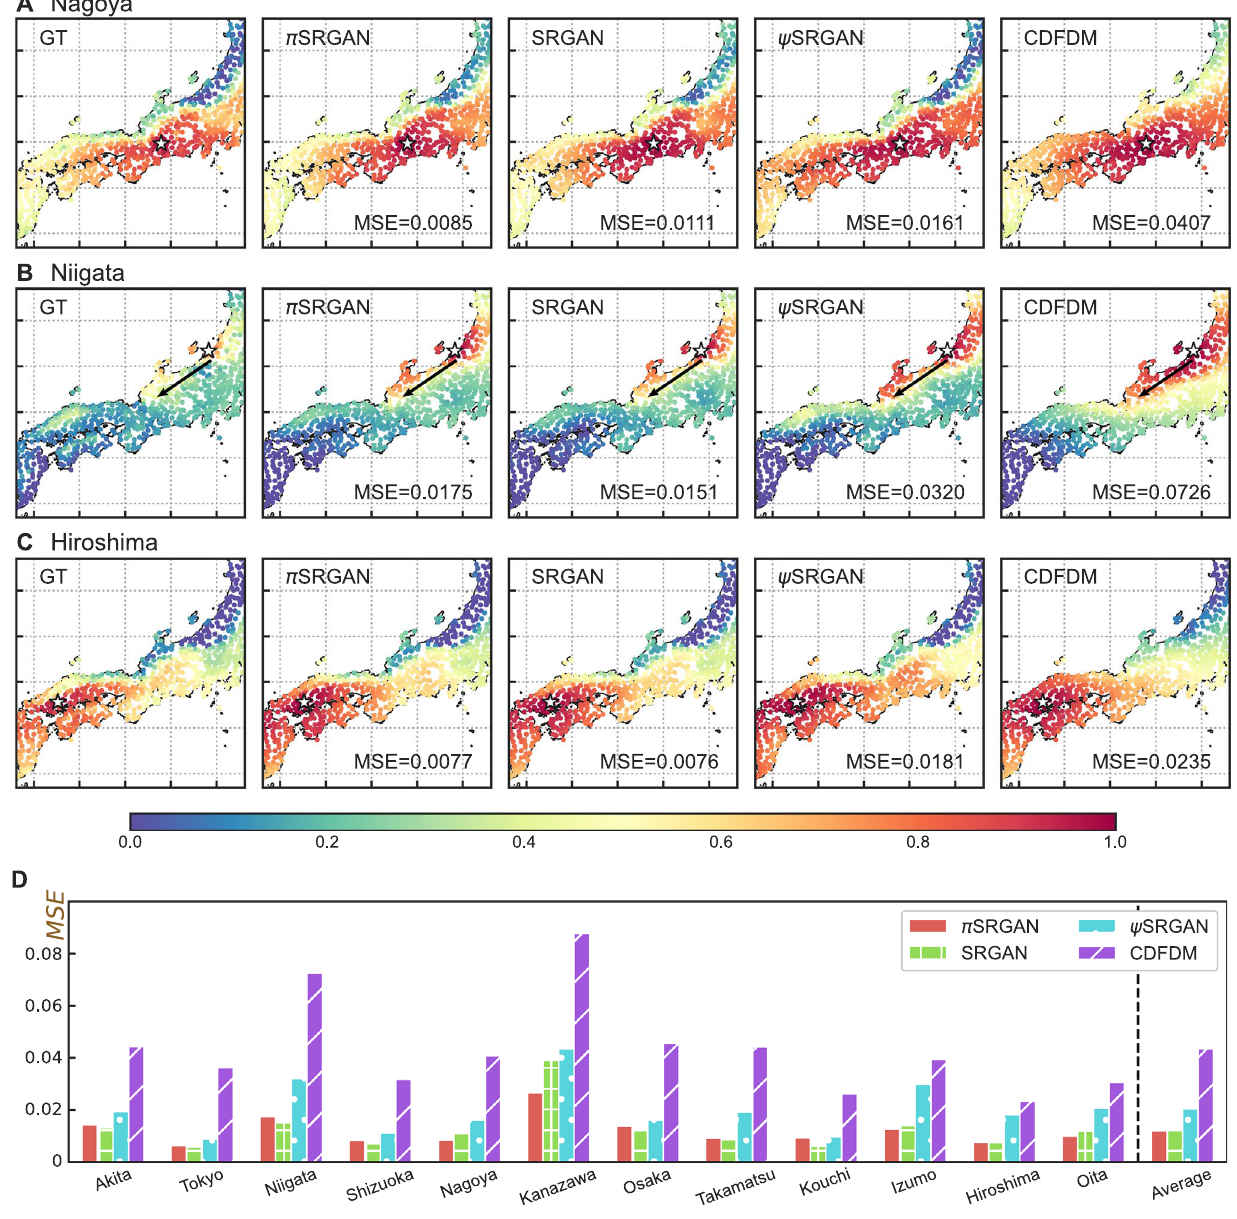
Figure 4. Spatial distribution of the correlation coefficients for precipitation. The distributions of January obtained with the π SRGAN, SRGAN, ψ SRGAN, and CDFDM are compared against the ground truth (GT) in the case of the reference point of correlation at Nagoya [35.1667 ◦ N, 136.965 ◦ E] ( A ), Niigata [37.9133 ◦ N, 139.0483 ◦ E] ( B ), and Hiroshima [34.365 ◦ N, 132.4333 ◦ E] ( C ). The dot color indicates the values of C R Jan ( l , l ′ ) between the location of the dots and the reference site. The reference points are represented by star symbols. ( D ) The mean square error (MSE) of the correlation coefficients of the downscaled precipitations from those of the ground truth. Although in panels ( A – C ), the longitude and latitude values are omitted for reasons of space, they correspond to the same values as in Fig. 3M.